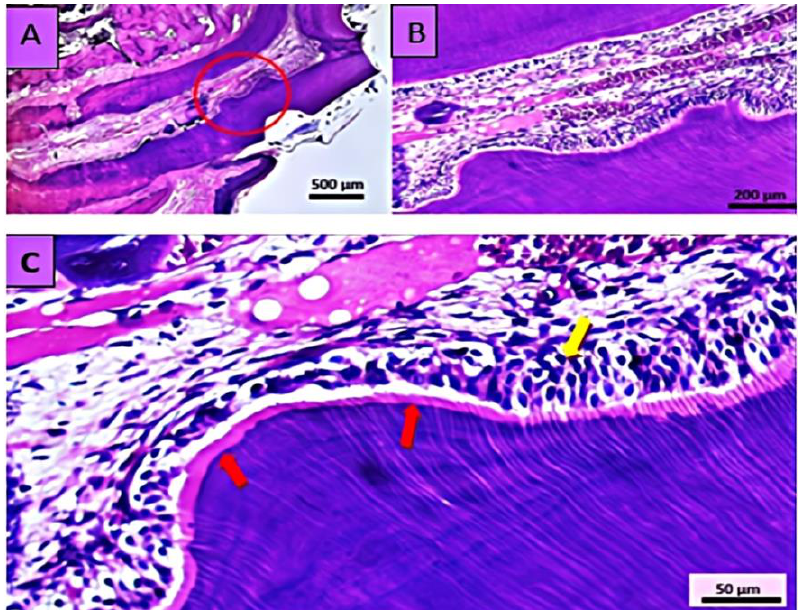
Figure 7. ( A – C ) (4×, 10× and 40×) (where ( B , C ) are magnified view of red encircled area of ( A ): Microscopic view of cervical restoration with nano-HA-SiO 2 -GIC. A very organized continuation of dentinal tubules can be seen with a normal palisade appearance (yellow arrow) of odontoblasts on either side of newly formed tertiary dentin, with dilated blood vessels. A clear distinctive pre-dentin can also be seen (red